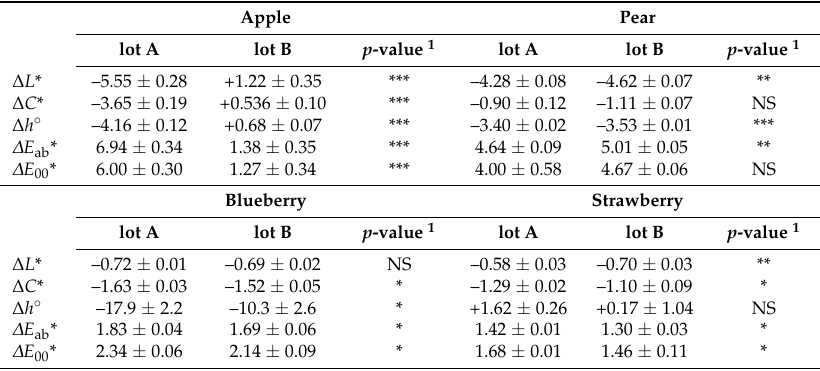
Table 5. Differences in lightness ( Δ L *), chroma ( Δ C *) and hue ( Δ h °) and Δ E ab * and Δ E 00 * color differences occurring with pasteurization in ricotta ‐ cheese whey ‐ fruit beverages for A and B lots and significance of Student’s t test ( p ‐ value).